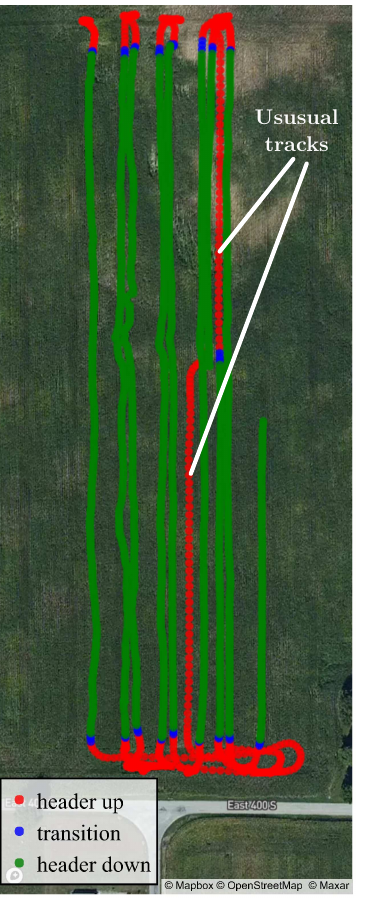
Figure 17. GPS track data, paired with contextual labels, can reveal information that cannot be easily obtained from GPS track only. For example, header position contexts provide a clear separation between harvest and non-harvest area in ( a